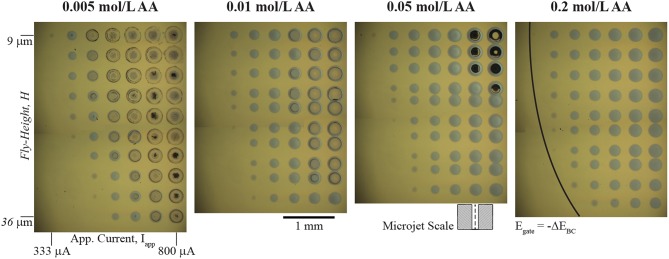
Optical micrographs of arrays of nickel deposits in 0.1 mol/L NiSO4 at the indicated ascorbic acid concentrations. 10 × 10 arrays of nickel deposits vary applied current (Iapp) from 100 to 800 μA (lowest 3 columns not shown) and nozzle fly-height (H) from 9 to 36 μm. Each deposit has a 5 s dwell time. A 200 μm ID nozzle at 400 μL/min electrolyte flowrate and deposit spacing of 400 μm was used for each experiment. Certain rows in the 0.01, 0.05, and 0.2 mol/L ascorbic acid arrays are more closely spaced than others due to a misstep in the y-axis motor during movement. The schematic of the microjet nozzle is provided for scale. The black line in the 0.2 mol/L array indicates the threshold potential (ΔEBC) to drive bipolar nickel deposition and ascorbic acid oxidation.